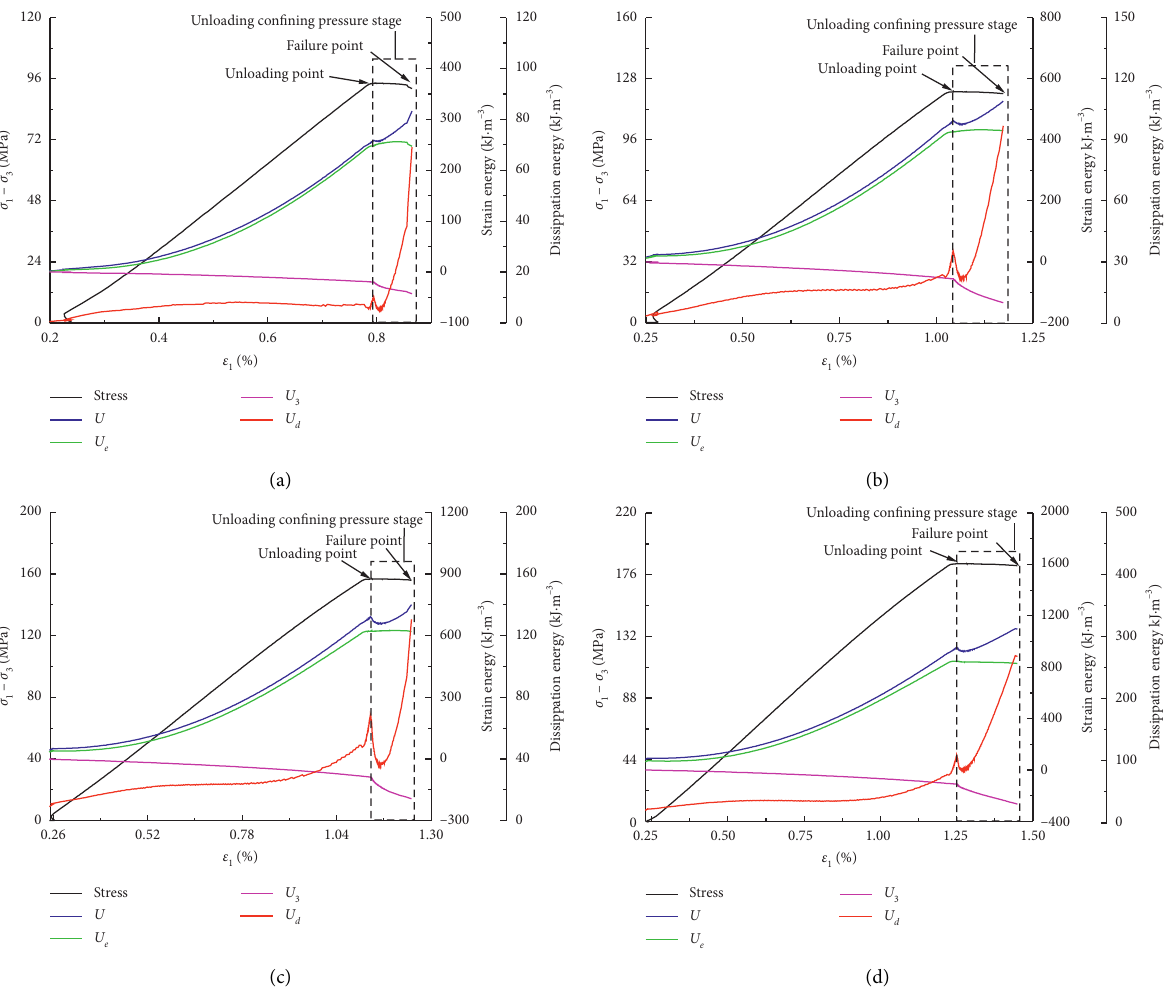
Figure 10: Energy transformation diagram of sandstone unloading failure under different initial confining pressures. (a) 10-e, (b) 20-d, (c) 30-b, and (d)